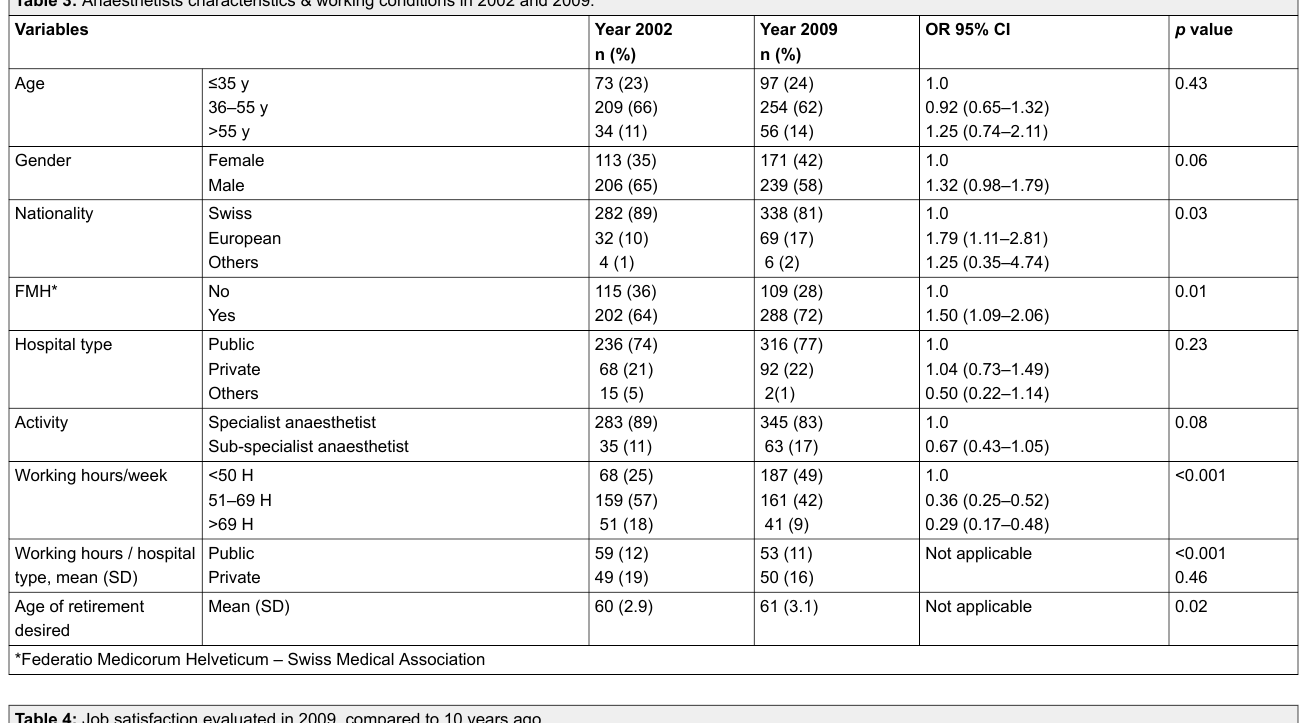
Table 4: Job satisfaction evaluated in 2009, compared to 10 years ago.